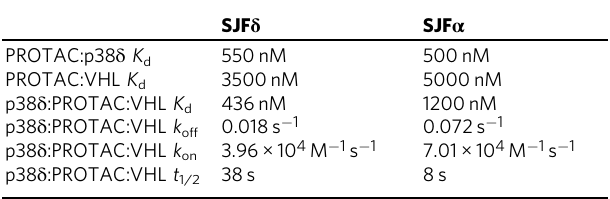
Table 1 Summary of binary (PROTAC:p38 δ or PROTAC: VHL) and ternary (p38 δ :PROTAC:VHL) af fi nity and kinetic